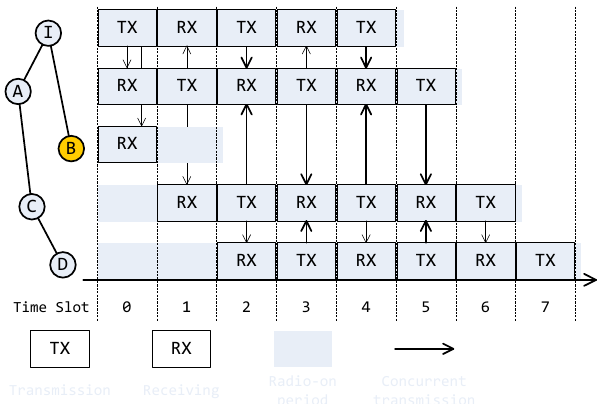
Figure 4. Nodes self-prune the connection links during the exploration phase. Node B (in dark yellow) then acts as an absorbing node and stays in receiving mode in a LiM round. In this example, node B in time slot 1 attempts to relax the listening time conservatively, in case that it misses the packet in slot 0